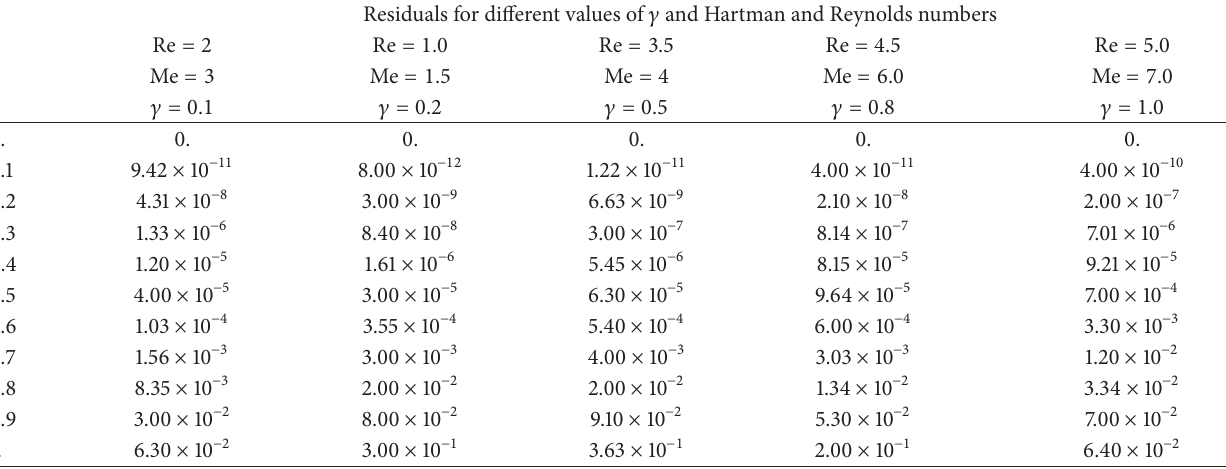
Table 5: Absolute residuals for different values of Me, Re, and 𝛾 with Re < Me. Residuals for different values of 𝛾 and Hartman and Reynolds